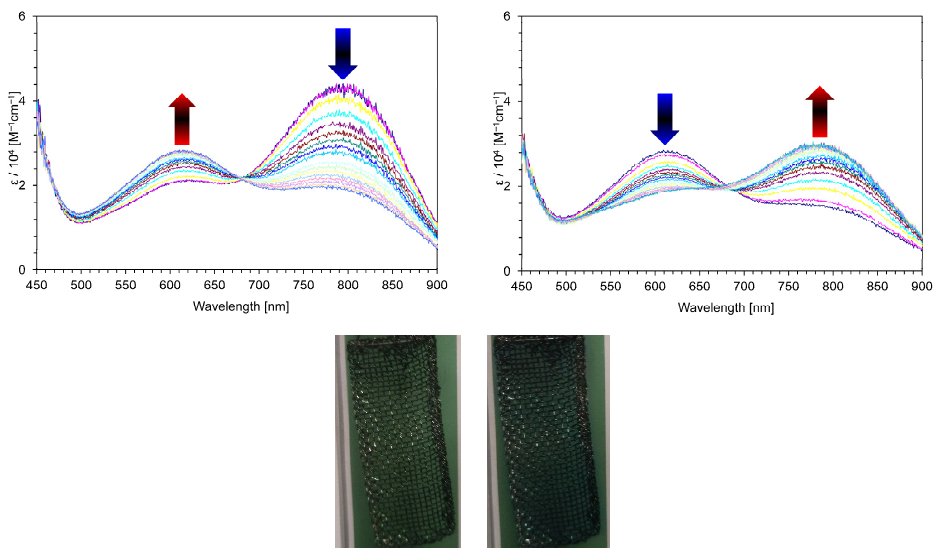
Figure 10. Continuous change in visible spectra of 4b 2+ · 2PF 6 − in benzonitrile containing Et 4 NClO 4 (0.1 M): constant-current electrochemical reduction (50 μ A) at 30 sec intervals ( top ) and the reverse oxidation ( bottom ) of the reduced species (50 μ A) at 30 sec intervals. Photo: Color changes of 4a 2+ · 2PF 6 − upon the electrochromic analysis in benzonitrile containing Et 4 NClO 4 (0.1 M) (50 μ A); before electrochemical reduction ( left ) and after electrochemical reduction ( right ).